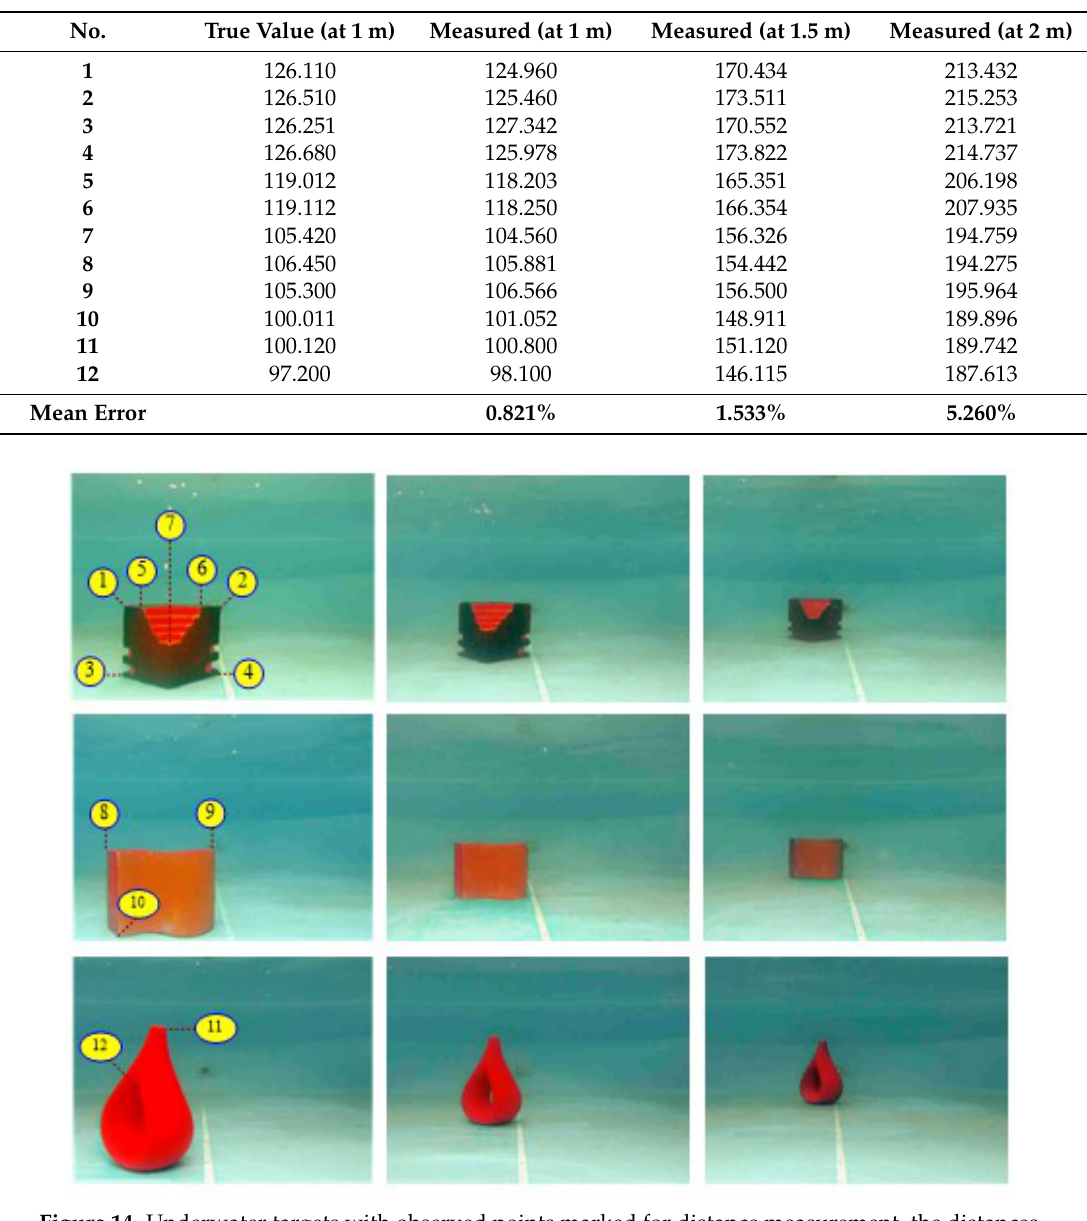
Table 7. Distance measurement experiments for underwater targets at different distances (unit: cm).